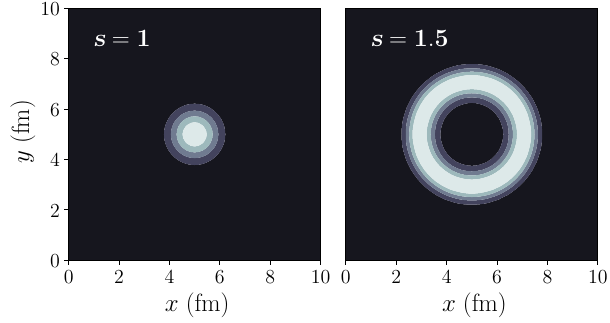
FIG. 9. The probability density from the instantaneous wave function at s = 1 of the quartic potential, and s = 1.5 with the addition of a quadratic